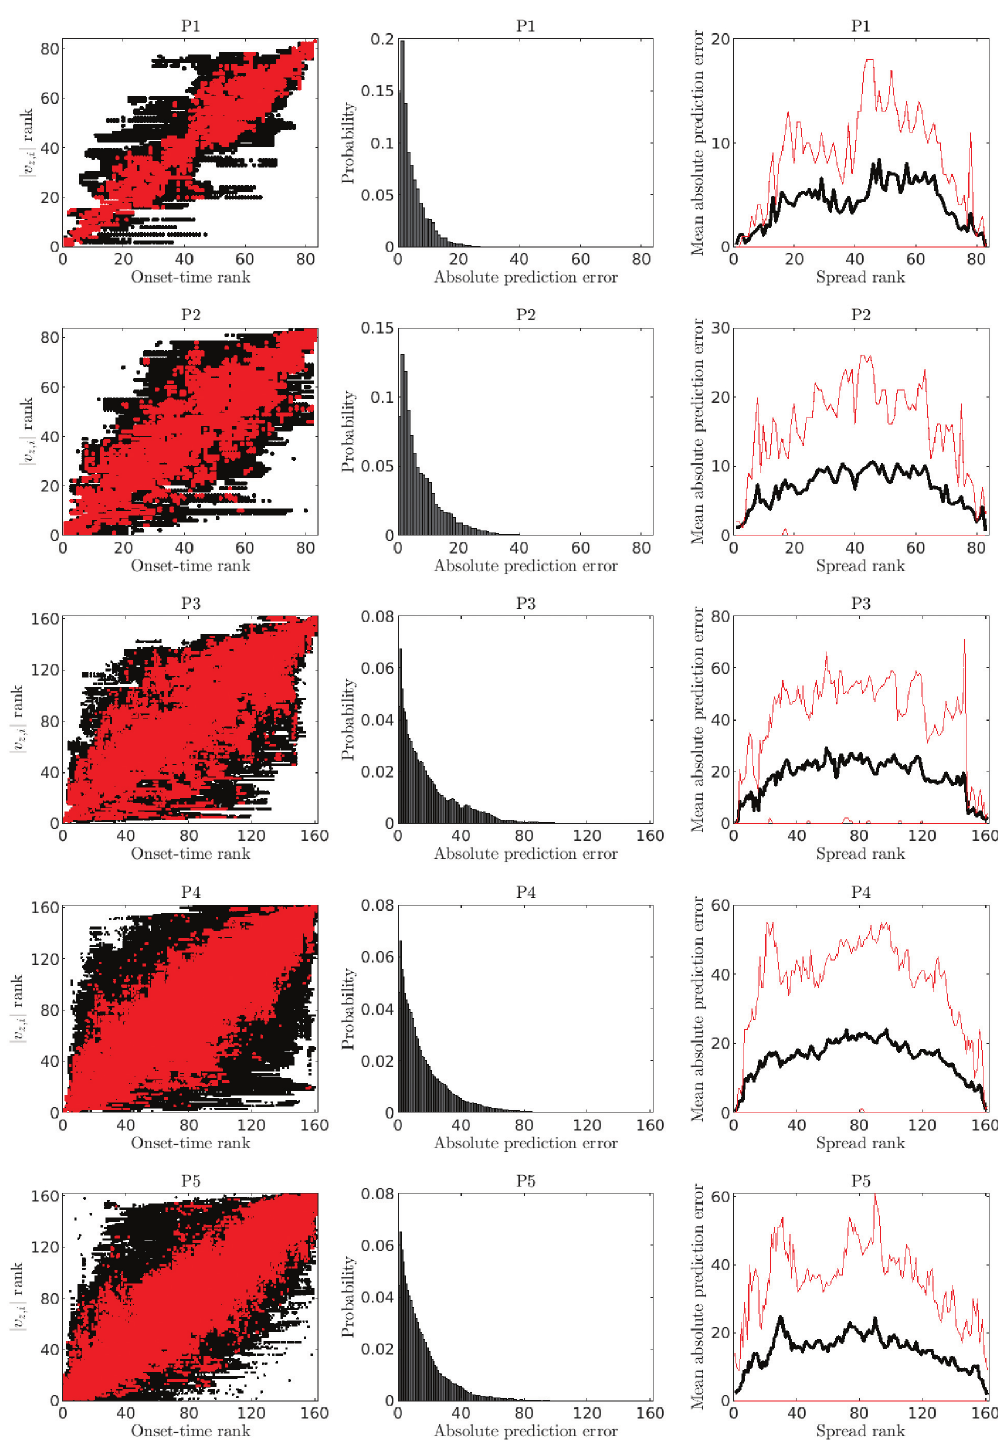
Fig 5. Prediction of temporal order of seizure spread based on linear stability analysis: Statistical summary. Each row corresponds to a different patient-specific connectivity (P1—P5 from top to bottom). Left column : the panels show the onset- time rank (rank 1 corresponds to a node which was first recruited into the seizure, and so on) and the corresponding seizure spread rank predicted by the ranked magnitudes of the leading eigenvector of the Jacobian matrix for a given epileptor network. As before, v indicates the eigenvector component related to the permitivity variable z in the i th node. Each black z , i dot corresponds to a network with a particular active EZ node, global connectivity strength and surrounding-node